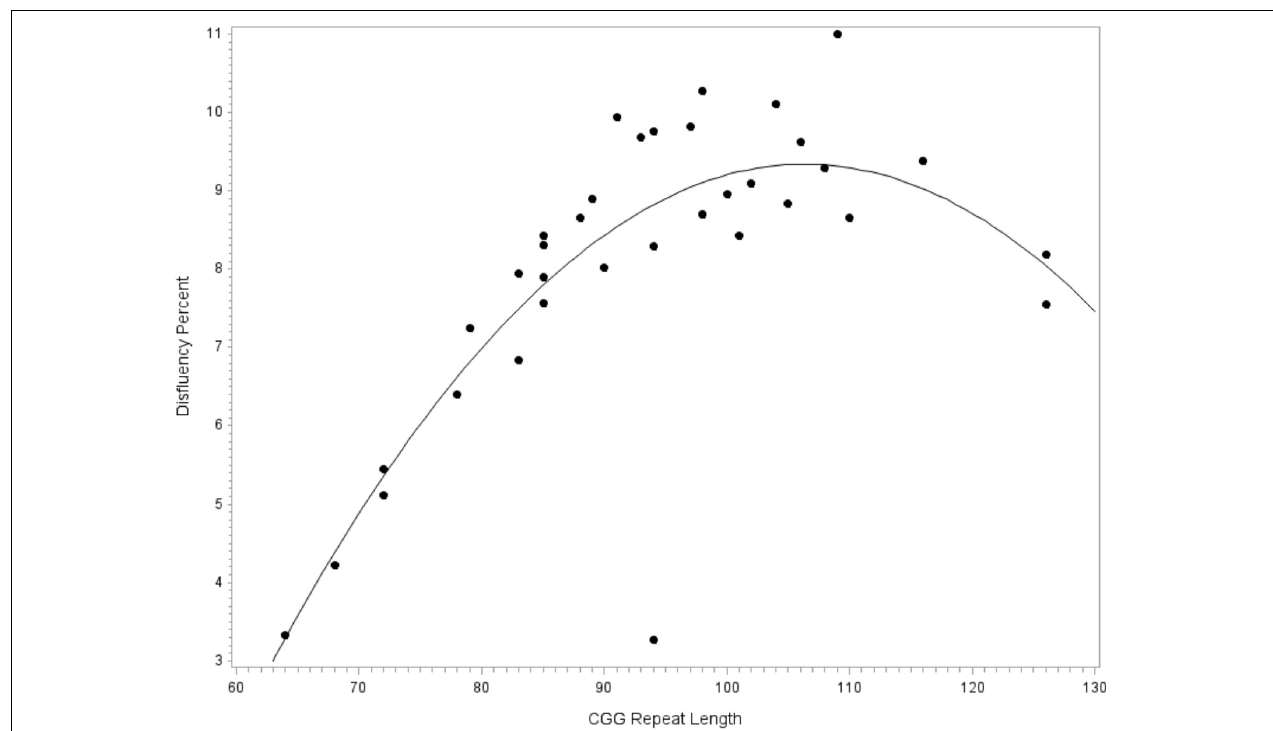
FIGURE 2 | Relationship between language disfluency and CGG repeat length across the premutation range. Quadratic association between CGG repeat length and disfluency. Model-predicted values are shown, controlling for age, education level, IQ, and allele-1 CGG